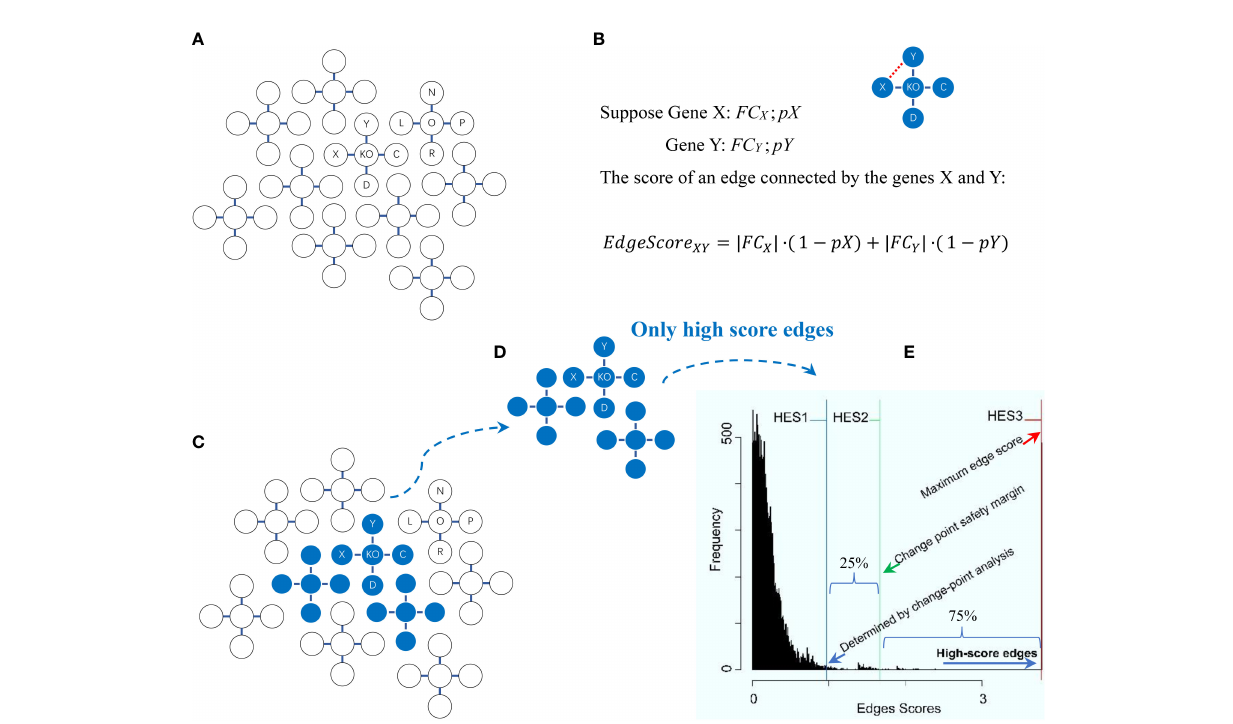
FIGURE 2 Schema of the high-edge-score (HES) approach with the change-point analysis method for statistically selecting differentially expressed genes. Explanations are presented in the main text. (A) A global graph is constructed. (B) An edge score for two genes (X, Y) in the global graph is calculated. (C) A change-point is statistically determined. (D) High score edges are statistically determined. (E) The distribution of edge scores is generated with each of three optional HES thresholds (HES1, HES2 and